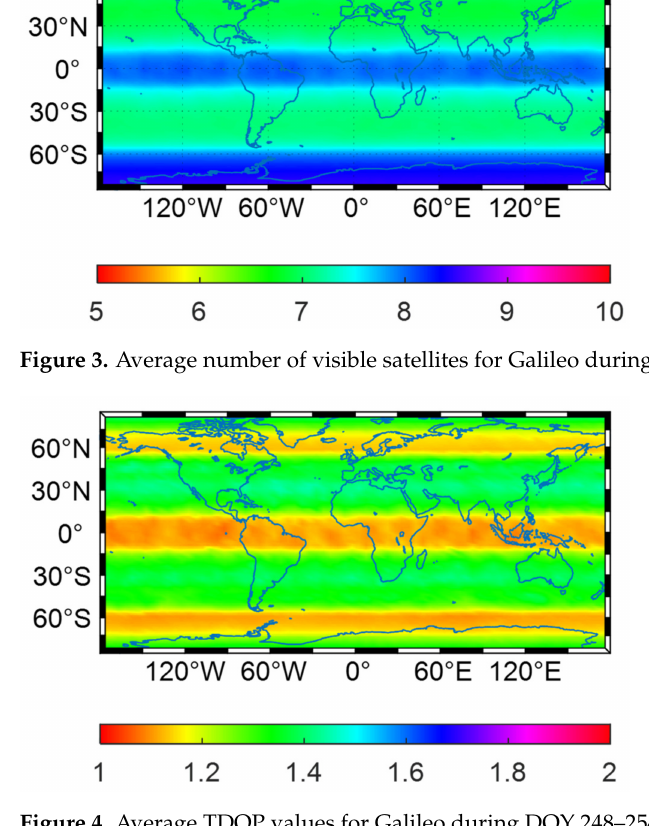
Figure 4. Average TDOP values for Galileo during DOY 248–254 of